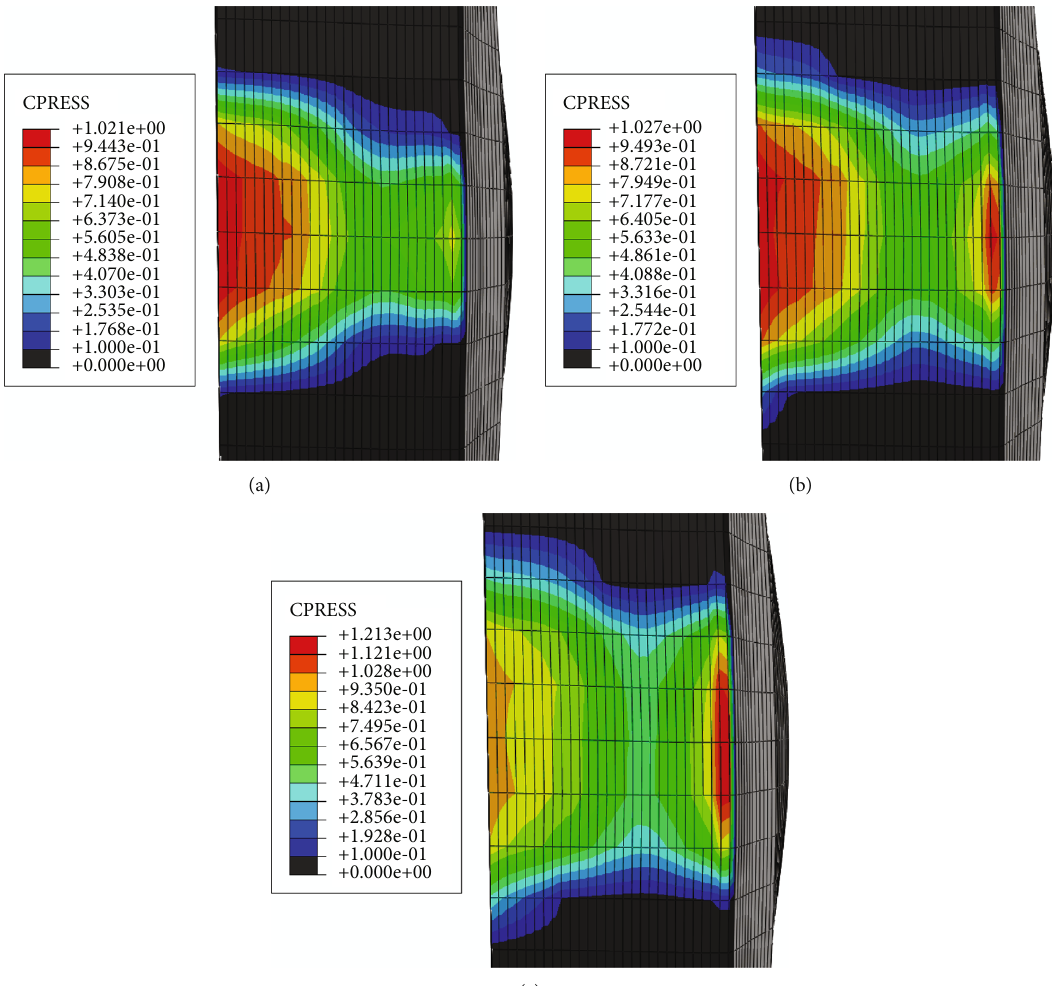
Figure 11: Grounding stress distribution of a 3D tire model under 0.55MPa of in fl ation pressure under loads of (a) 466670 N, (b) 555550N, and (c) 633330